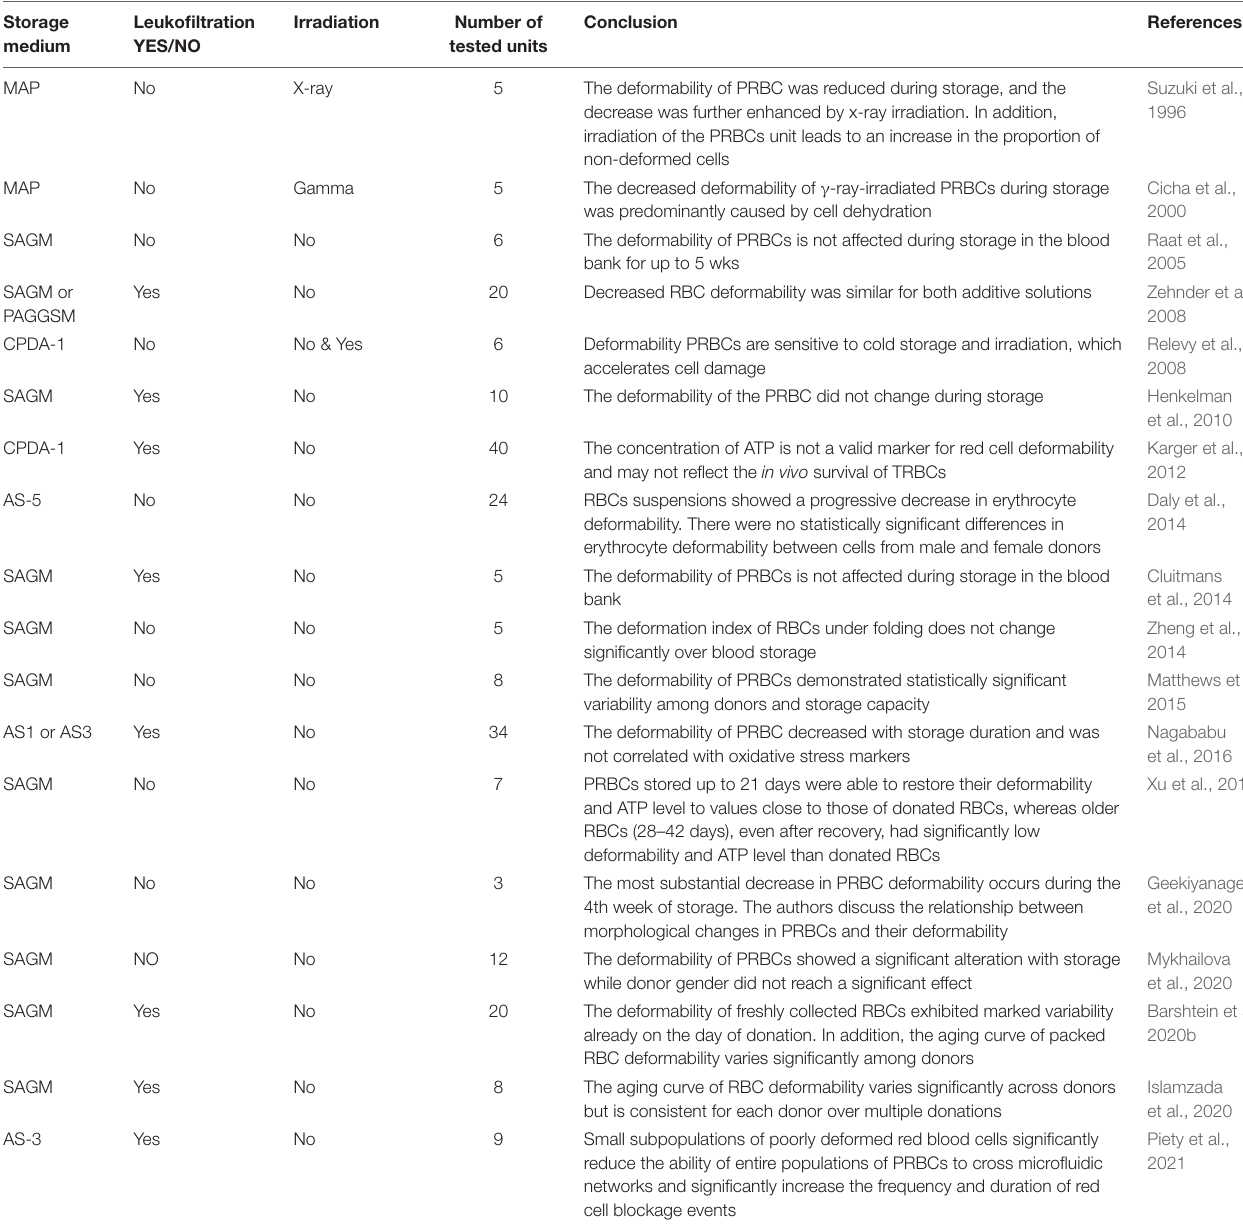
TABLE 1 | Deformability of packed RBC during their